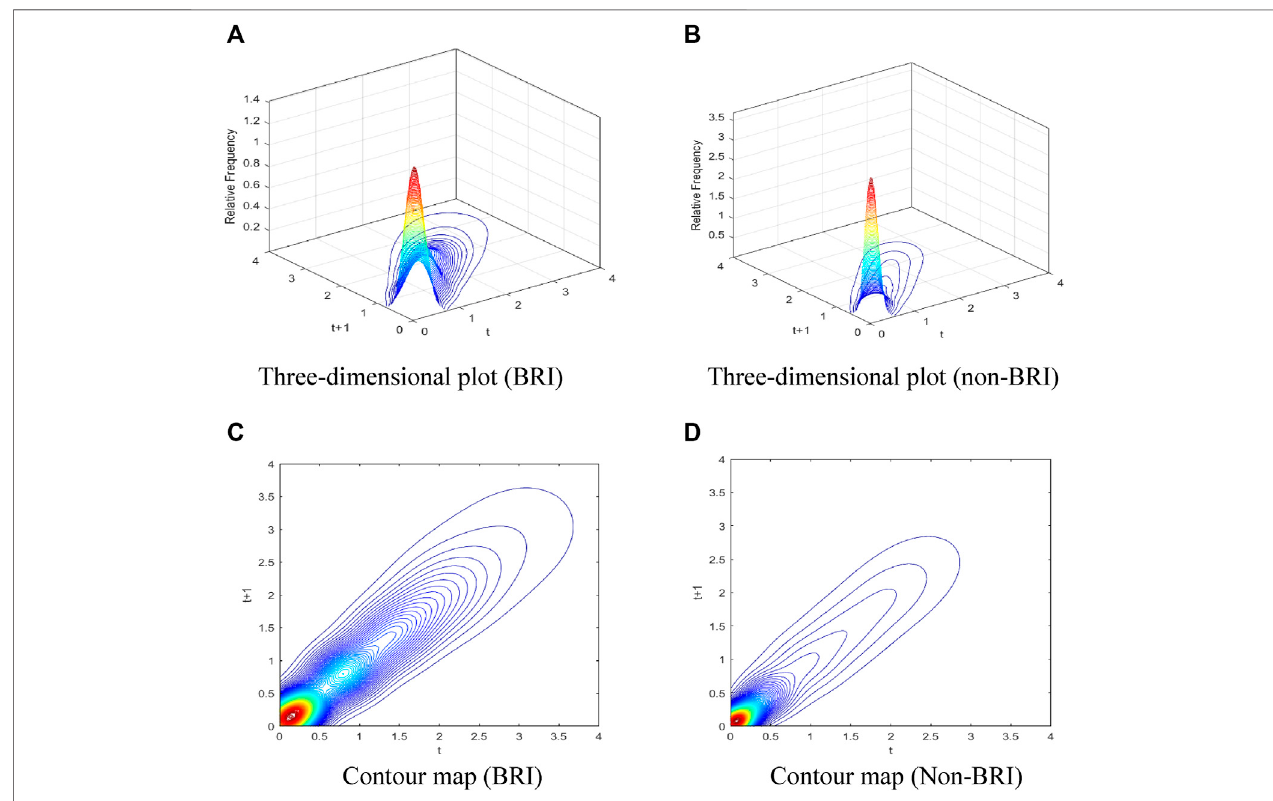
FIGURE3| Three-dimensionalplotandContourmapoftransitionalprobabilitykernelforcarbon emission percapitawithyearlytransitions,from1987to2014. (A) Three-dimensional plot (BRI). (B) Three-dimensional plot (non-BRI). (C) Contour map (BRI). (D) Contour map (Non-BRI).